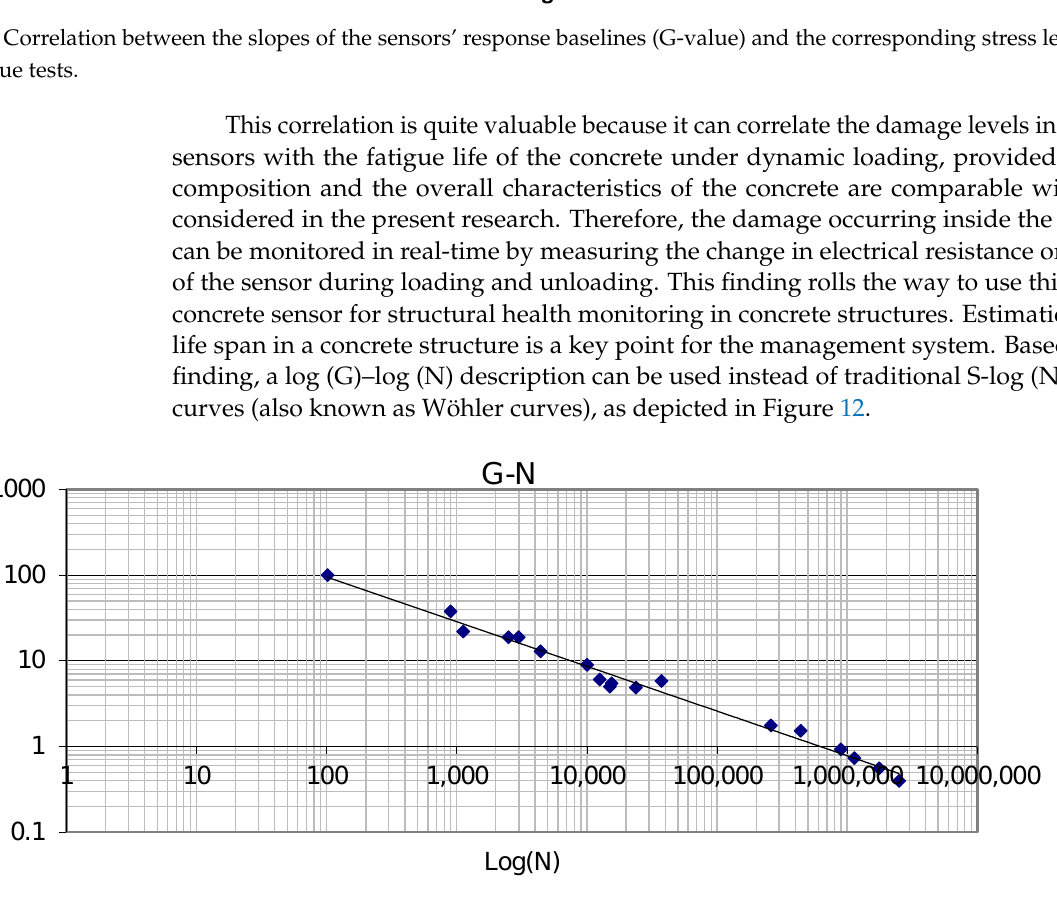
Figure 12. Relationship between the slope of the sensors’ response baseline and fatigue life for different stress levels.